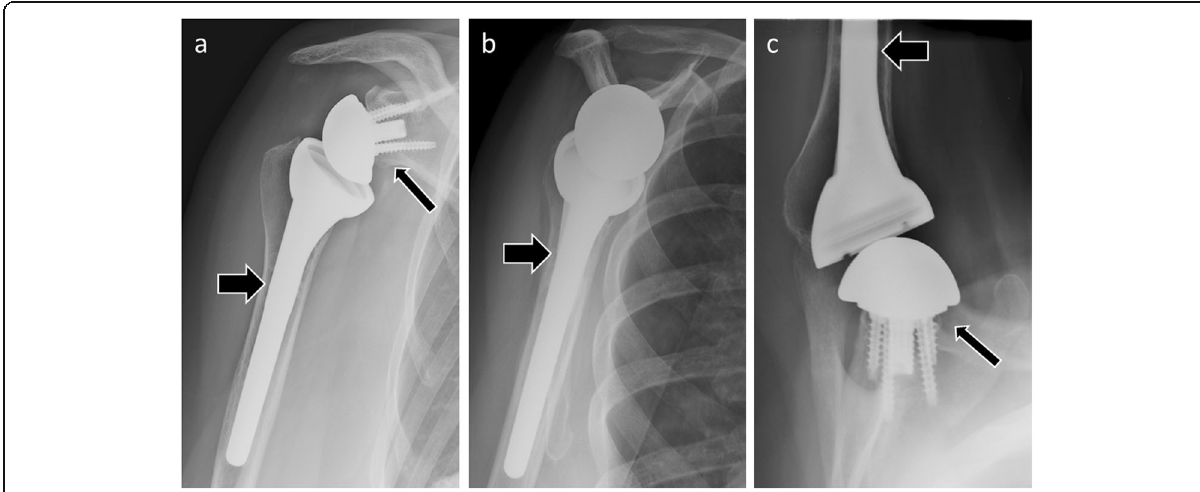
Fig. 2 Anteroposterior ( a ), scapular Y ( b ), and axillary ( c ) radiographs of normal findings in a patient with reverse shoulder arthroplasty. The humeral prosthetic stem (thick arrows) is centered within the humeral shaft. The glenosphere (thin arrows) is placed flush with the native glenoid (or slightly lowered) and the humeral component is centered on the glenosphere